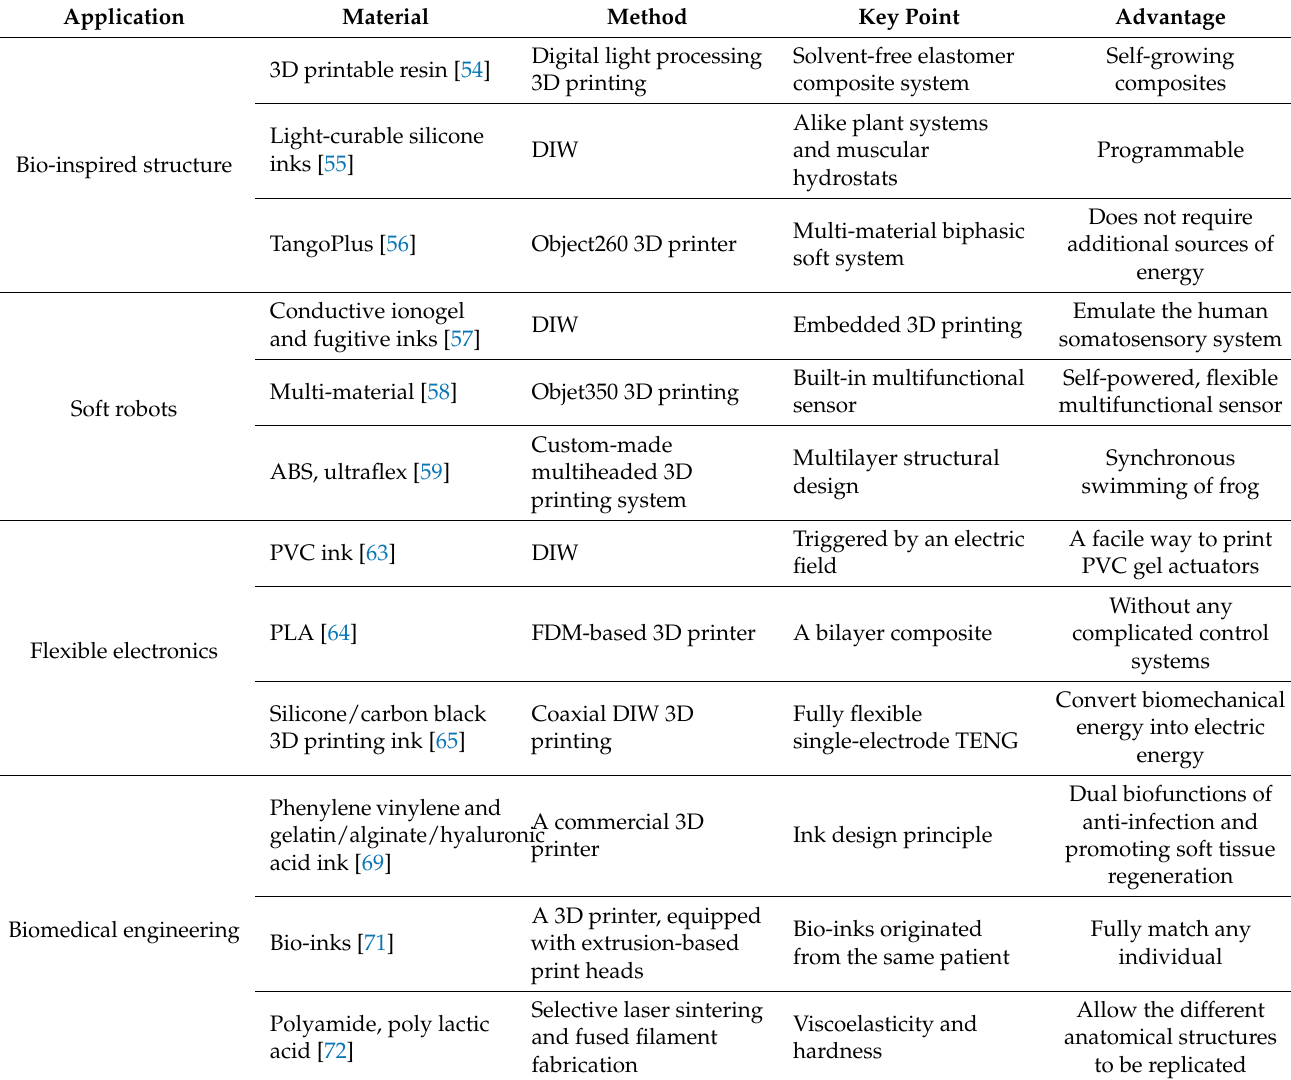
Table 2. Summary of 3D printing